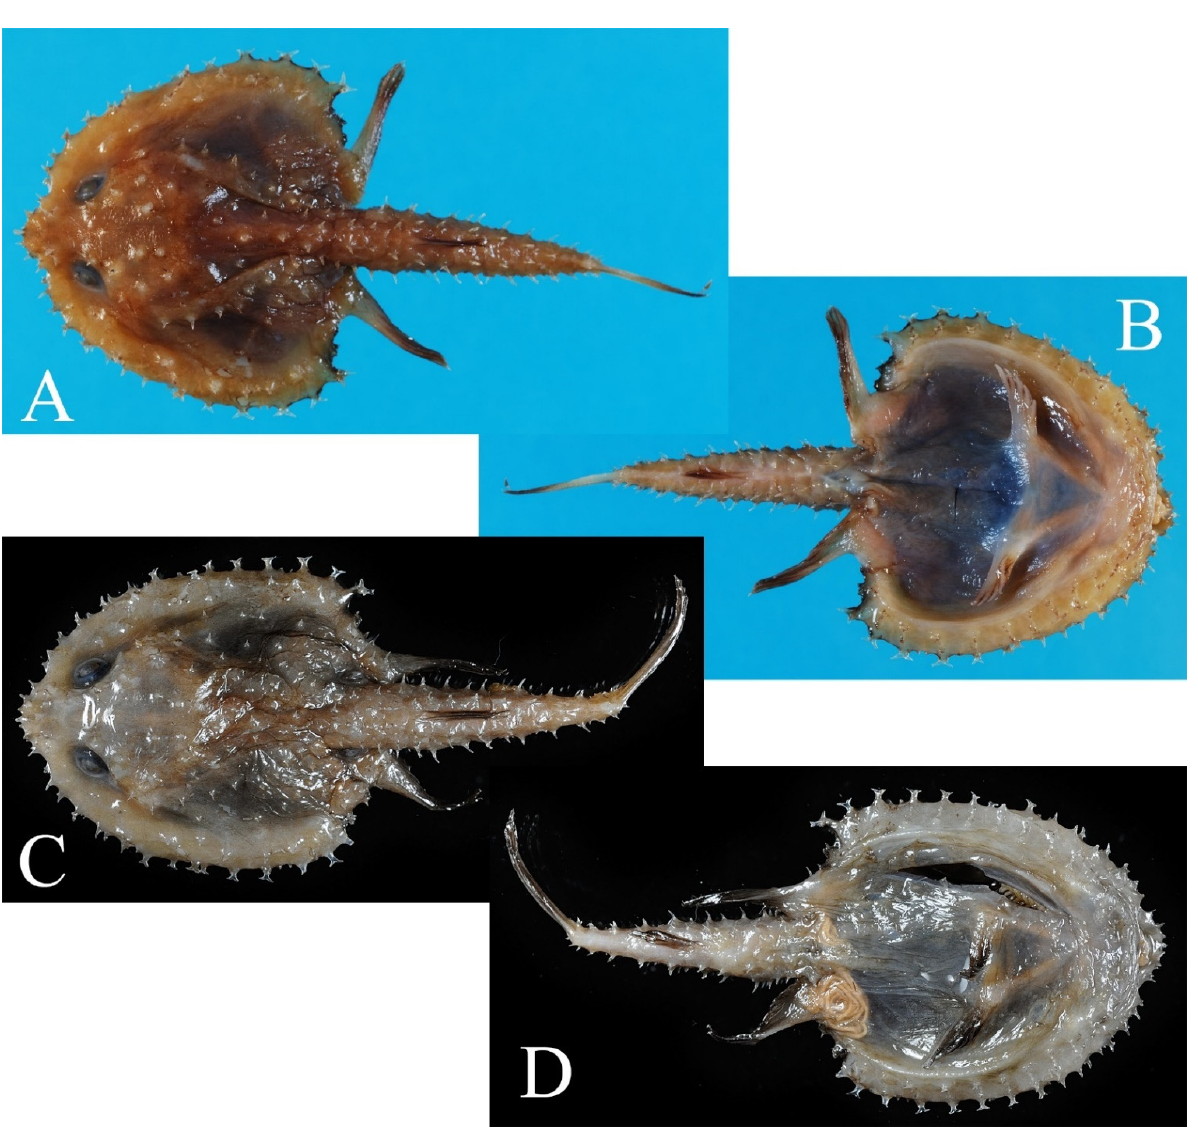
Figure 22. Halieutopsis nudiventer (Lloyd, 1909). ( A , C ). Dorsal view. ( B , D ). Ventral view. ( A , B ). AMS I.29757-002, 74.7 mm SL. ( C , D ). NSMT-P101904, 70.4 mm SL, photos courtesy of NSMT.